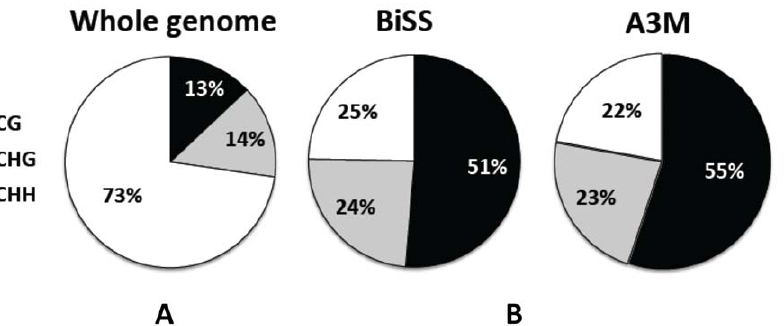
Figure 1. Distribution of cytosine sequence context. (A) Frequency of sequence context in the reference genome. (B) Frequency of sequence context of methylated C according to BiSS and A3M.